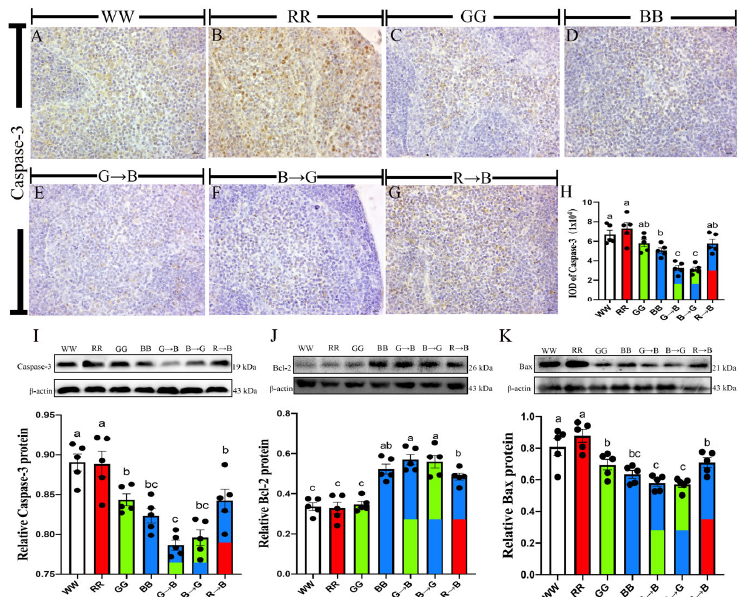
Figure 1. Immunohistochemical staining of Caspase ‐ 3 (scale bar = 50 μ m) in WW ( A ), RR ( B ), GG ( C ), BB ( D ), G → B ( E ), B → G ( F ), R → B ( G ), IOD of Caspase ‐ 3 positive cells ( H ), Caspase ‐ 3 protein ( I ), Bcl ‐ 2 protein ( J ), Bax protein ( K ) in the bursa at P42. The results of each group were expressed as the mean ± standard error. Differences between seven light treatment groups were evaluated by one ‐ way ANOVA, and values with no common letters differ significantly ( p < 0.05).